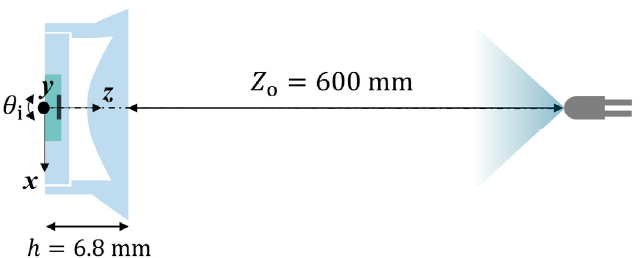
Figure 4. Measurement setup for the optical concentration ratio g o.